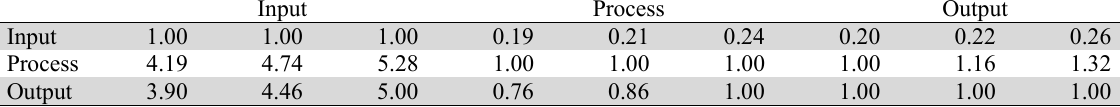
Aggregated fuzzy comparison matrix of factor production to goal EG